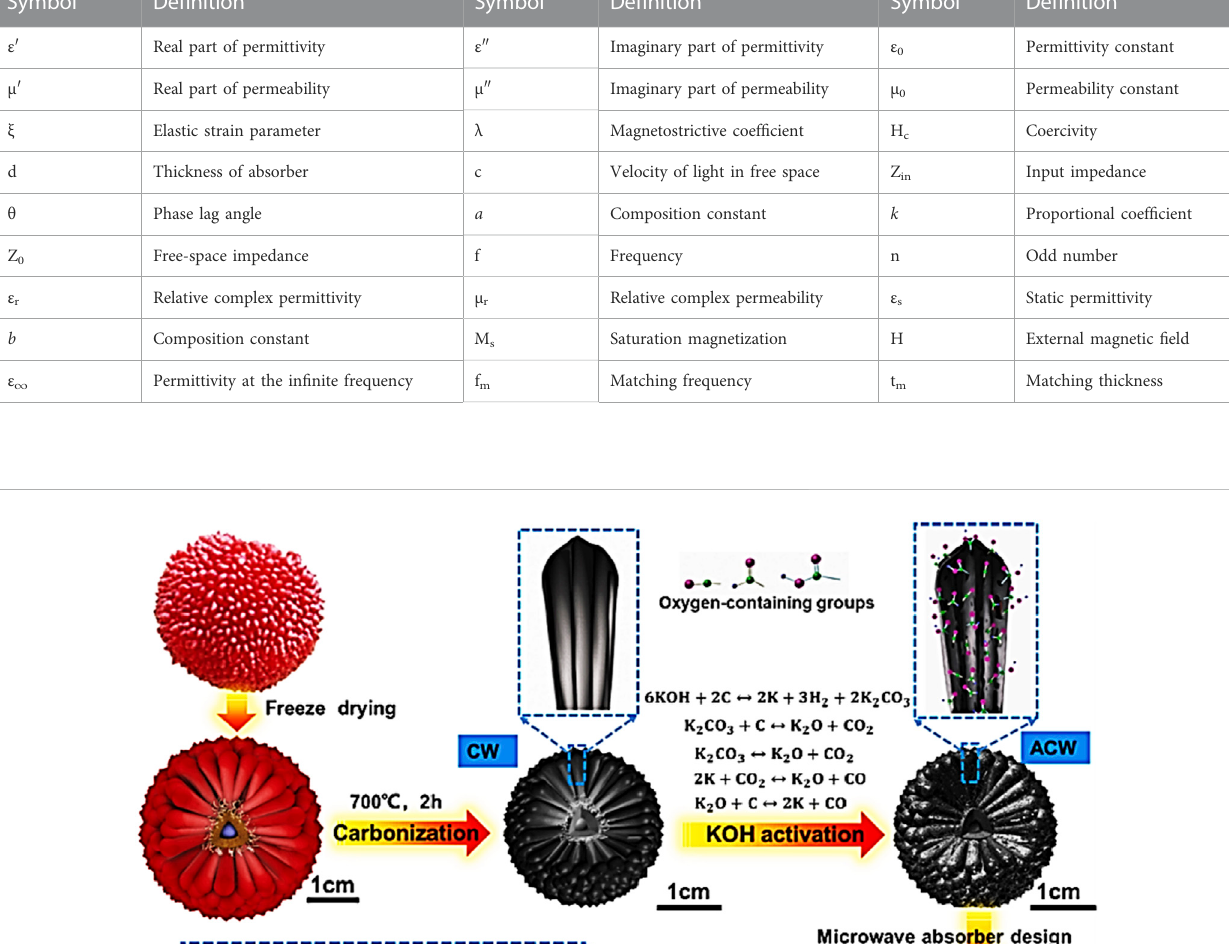
TABLE 3 De fi nitions of the symbols used to evaluate the microwave-absorbing features.